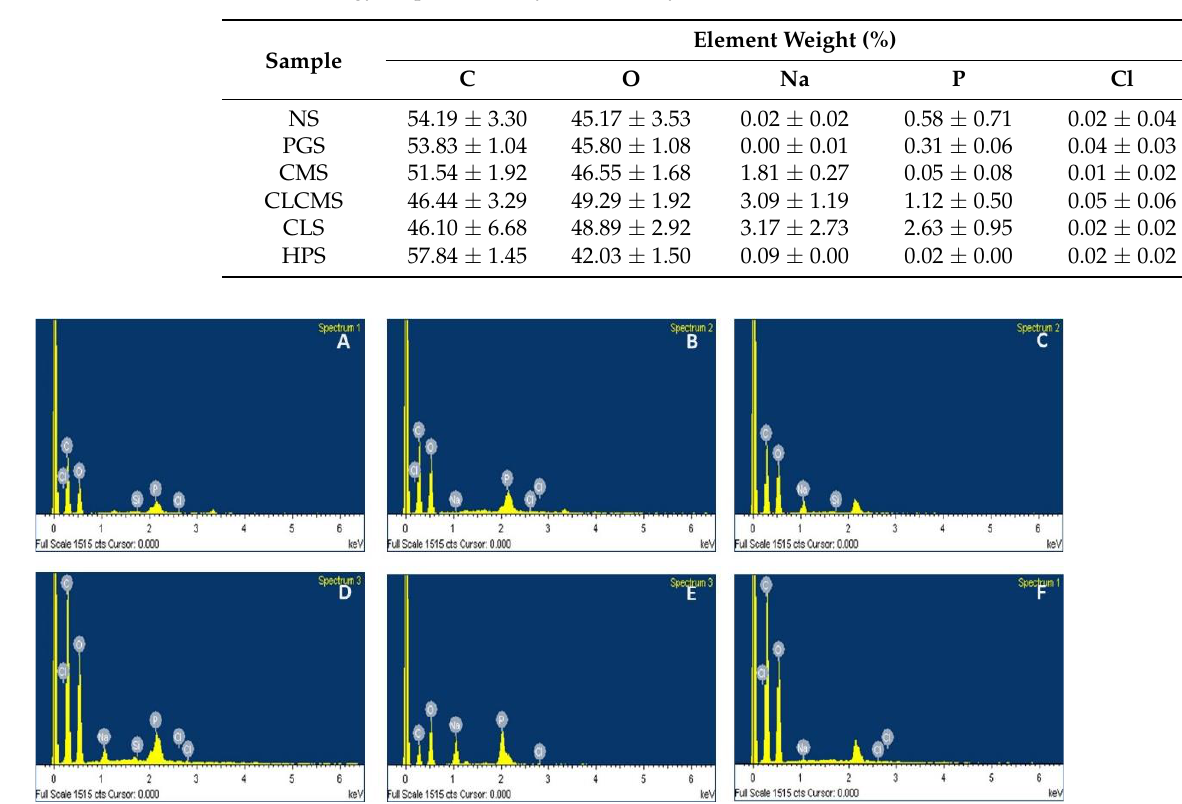
Table 1. Energy-dispersive X-ray (EDX) Analysis of Native and Modified KJ CMU-107 Starches.